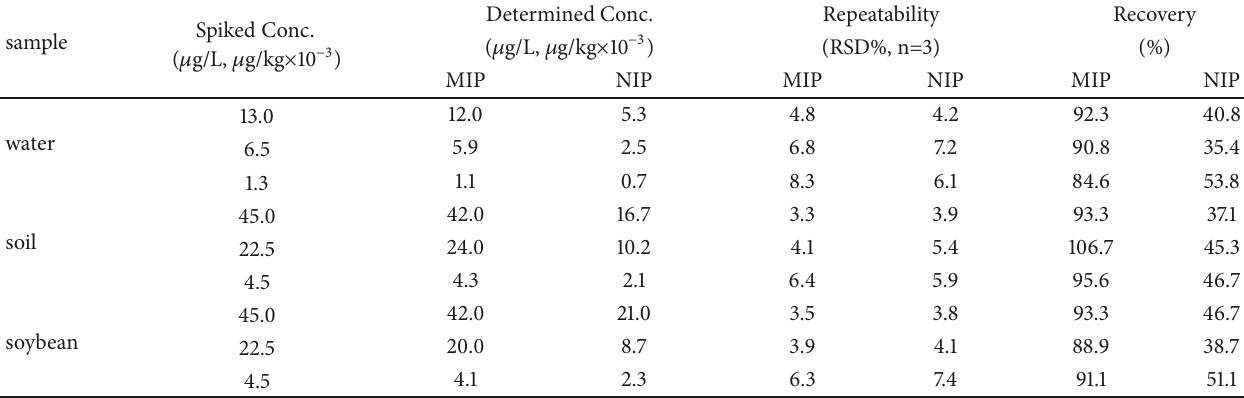
Table 2: Recoveries of TBM on MIL@MIP and on MIL@NIP for spiked water, soil, and soybeans samples. Spiked Conc. sample